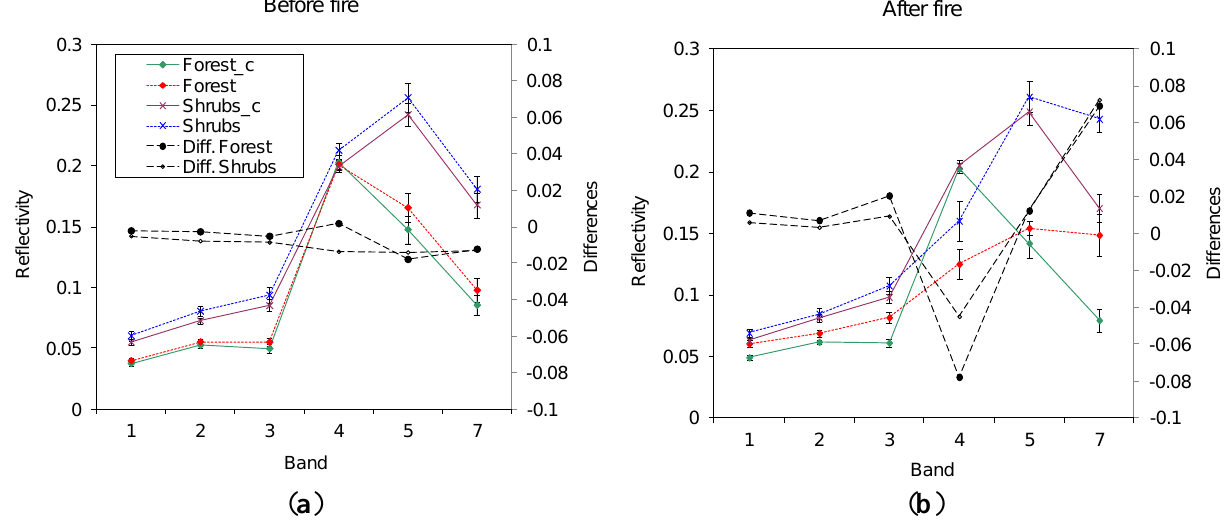
Figure 3. Average reflectivity values, and their corresponding error bars, for each one of the selected areas (colored lines), and differences between fire-affected sites and their corresponding control areas (black lines): ( a ) before the fire, and ( b ) after the fire. Spectral ranges for